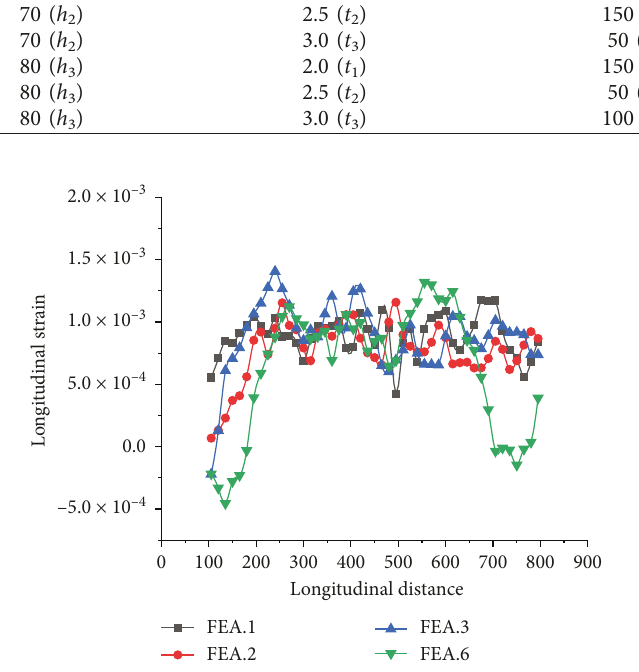
Figure 16: Longitudinal strain curves of the sheet metal along longitudinal position in Exp. 1, 2, 3, and 6. Table 4: Range analysis of orthogonal experimental